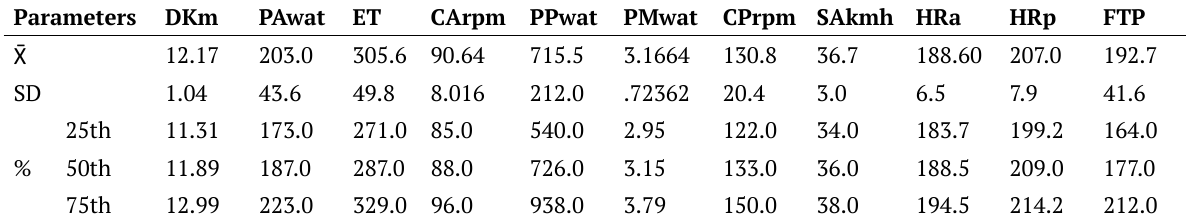
Table 1. Descriptive statistics and level of the FTP and its parameters Parameters